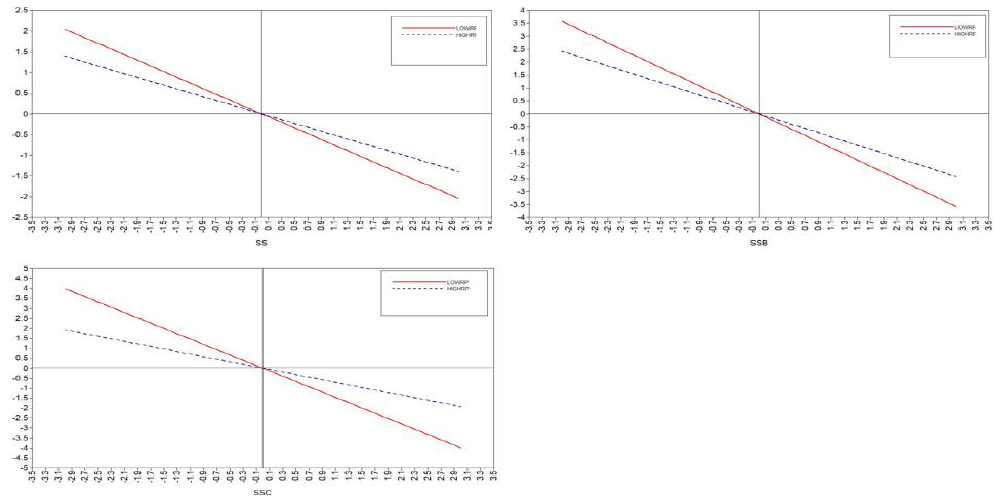
Figure 3. The moderating effect of psychological resilience on the relationship between social support and employment stress.